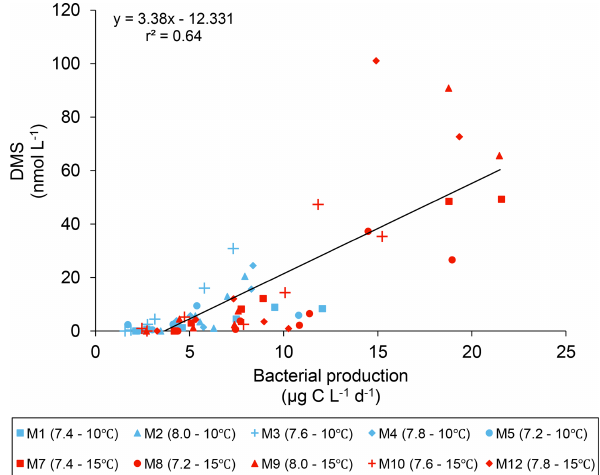
Figure 6. Linear regression between DMS concentrations and bac- terial production during the